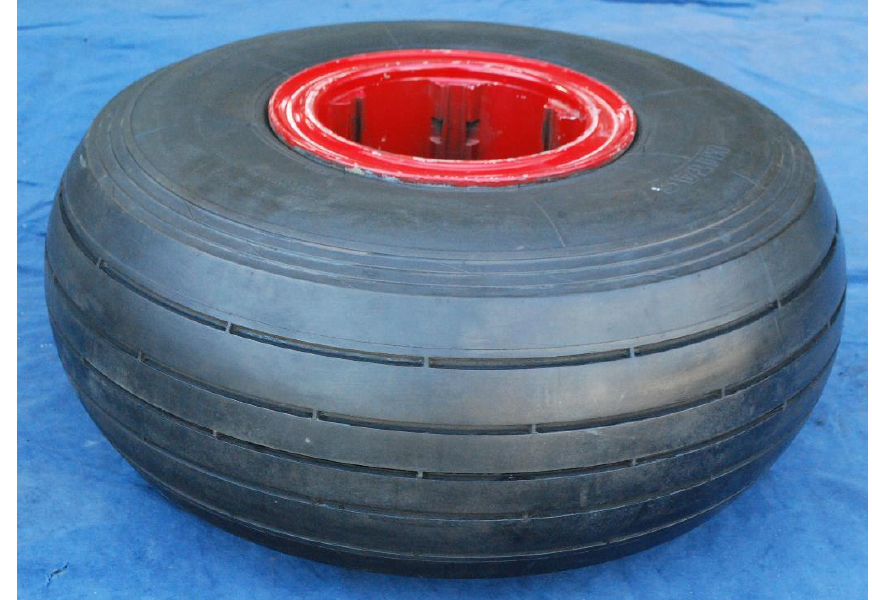
Figure 2. PZL M28 Skytruck/Bryza tire.